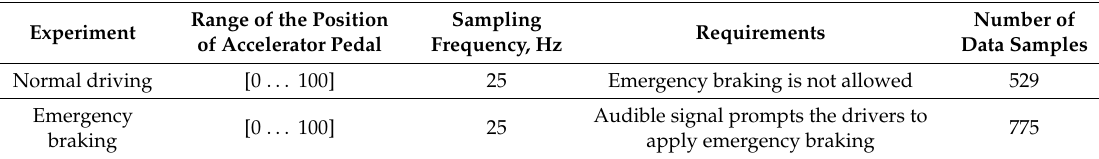
Table 3. Details of the two series of